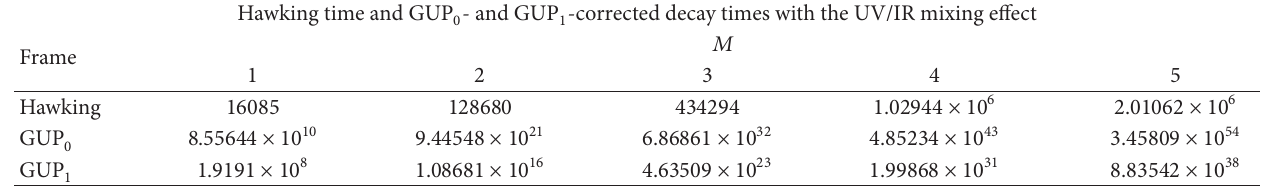
Table 3: Hawking time and GUP 0 - and GUP 1 -corrected decay times with the black hole mass 𝑀 = 1, 2, .. ., 5 (in Planck units) and 𝛼 = 1 .